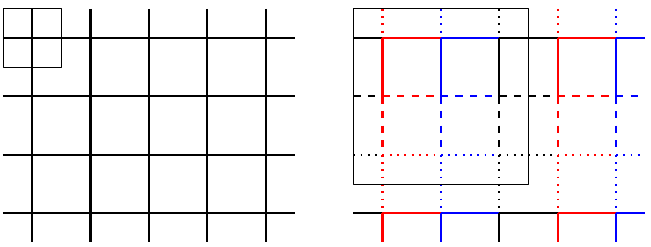
Figure 8 . The re(cid:12)nement of the G(cid:127)urdo(cid:21)gan-Kazakov’s model with two (cid:13)avour indices a; b 2 f 1 ; 2 ; 3 g super-selects from the (cid:12)shnets of the original proposal (left) only those compatible with the resulting 3 (cid:2) 3 color structure (right). The distinction is important when we study the diagrams which wrap a cylinder, such as those that compute anomalous dimensions of tr (cid:30) L . The minimal periodic structure that allows to put the construction on the cylinder is in each case the unitary cell enclosed by a thin